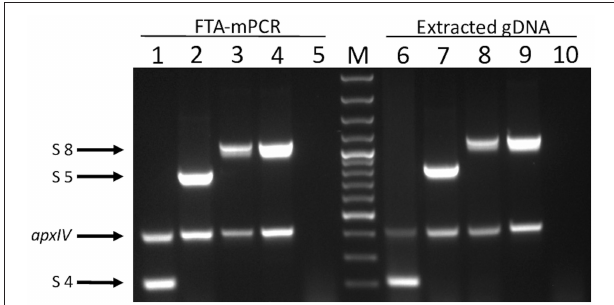
FIGURE 3 | Products of APP-mPCR1 amplified directly from lung tissue imprints on FTA ® cards (lanes 1–5) and extracted genomic material extracted using commercial kits from the same lung tissues (lanes 9–10). Lanes 1 and 6 = serovar 4; lanes 2 and 7 = serovar 5; lanes 3, 4, 7, and 9 = serovar 8; and lanes 5 and 10 = an APP-negative lung. Lane M = 100 bp Plus DNA Ladder (GeneRuler, Thermo Fisher